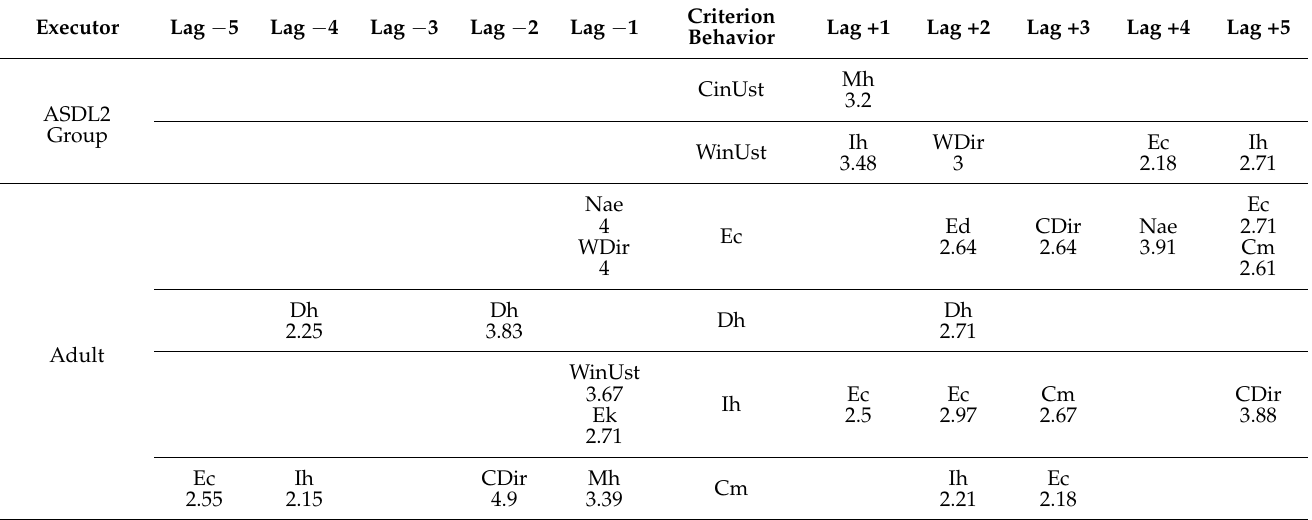
Table 6. Behavioral patterns obtained in the ASDL2 Group at the beginning of the intervention. Central column = It contains the criteria behaviors. Remaining cells = They contain the conditional behaviors. Numbers = Significant adjusted residuals values. Green codes = The most relevant behaviors indicating children progress in interference control. Red codes = The most relevant wrong interference control behaviors of the children. Blue codes = The most relevant adult scaffolding